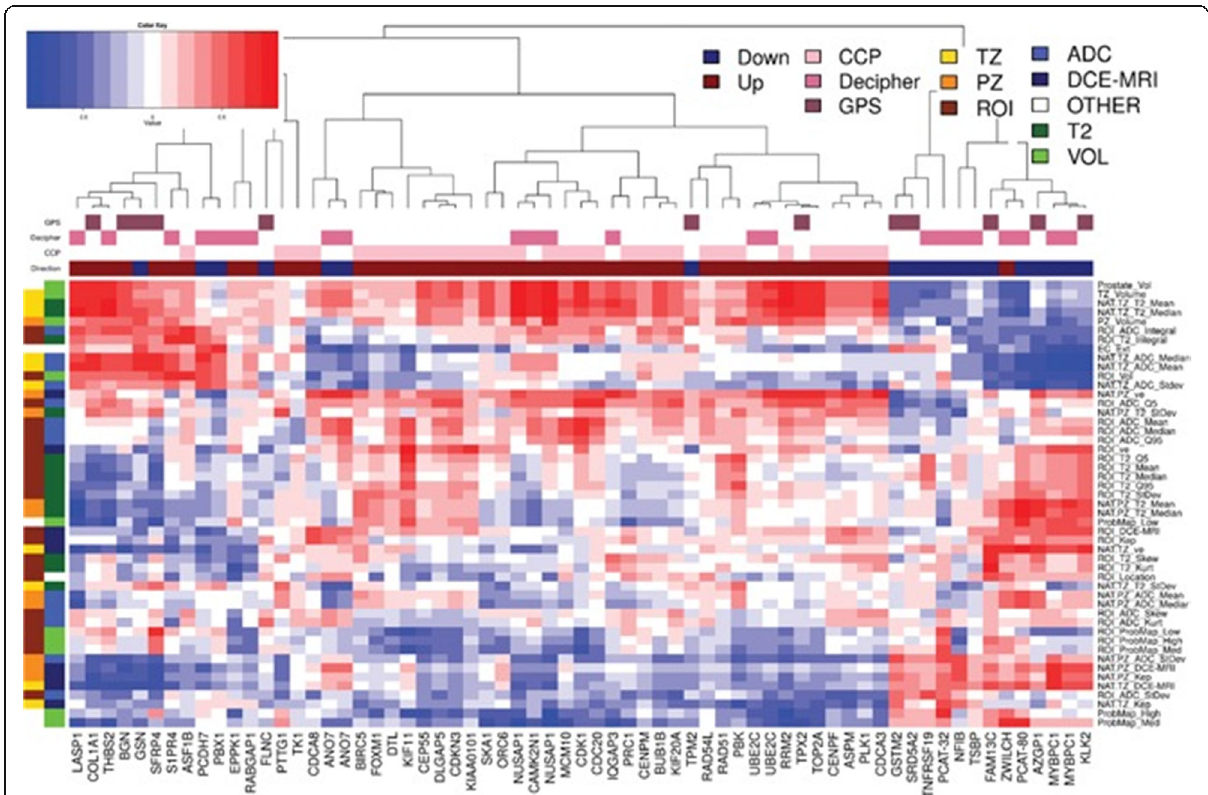
Fig. 9 Pearson ’ s correlation analysis of imaging features and 65 genes from commercially available prostate cancer classifiers. Hierarchical clustering on Pearson ’ s correlation distance between radiomic features and genes from commercially available prostate cancer classifiers: CCP (Cell Cycle Progression), Decipher and GPS (Genomic Prostate Score). Genes in these signatures that are up-expressed in aggressive cancers are indicated by a dark red box over the gene ’ s column while those that are down-expressed are indicated with a blue box. Groups of radiomic features are indicated along the dendrogram on the left. Group1 (left) connects the radiomic feature with location (TZ, PZ and ROI); group 2 is related to the image modality/function: T2w, ADC, and DCE-MRI. Reprinted under a creative commons license from: Buerki C, Castillo R, Jorda M, Ashab HA, Kryvenko ON, Punnen S, Parekh D, Abramowitz MC, Gillies RJ, Davicioni E, Erho N, Ishkanian A. Association of multiparametric